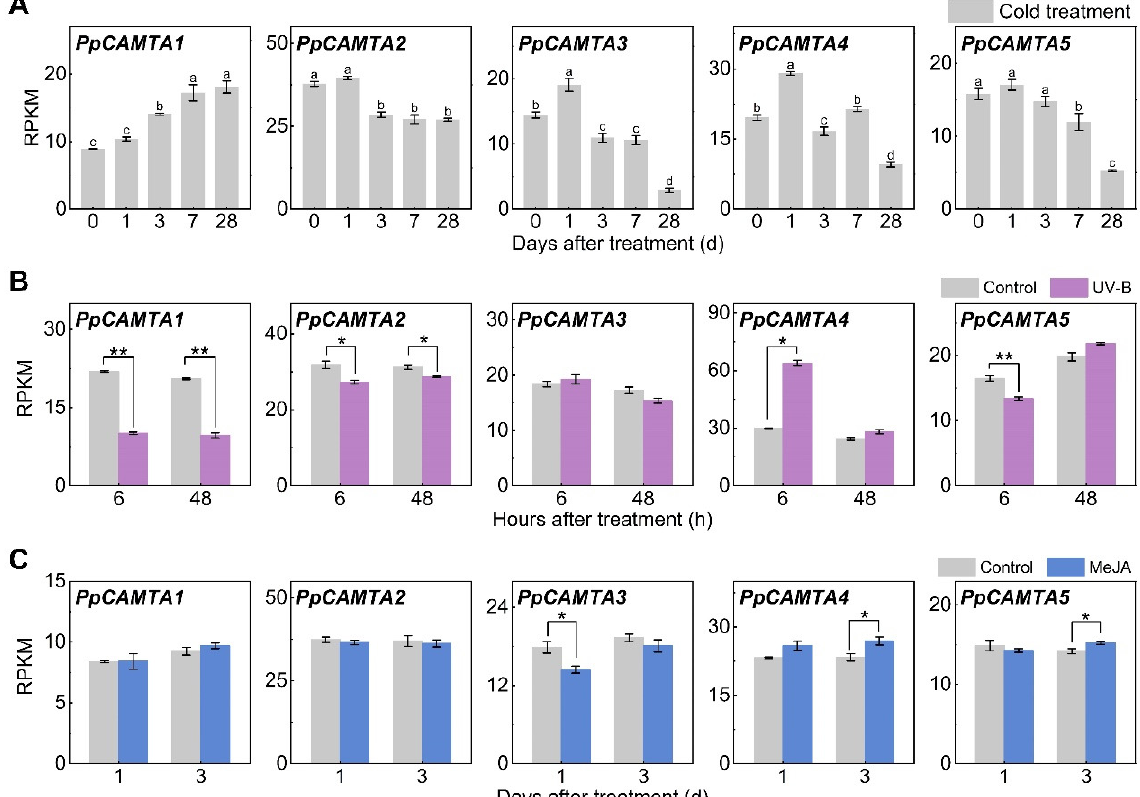
Figure 4. Expression patterns of peach CAMTA genes responding to abiotic stresses. ( A ) Cold treatment. ( B ) UV-B treatment. ( C ) MeJA treatment. Means and standard errors were calculated from three replicates. Different letters ( p < 0.05) and asterisks (*, p < 0.05; **, p < 0.01) above the bars represent significant